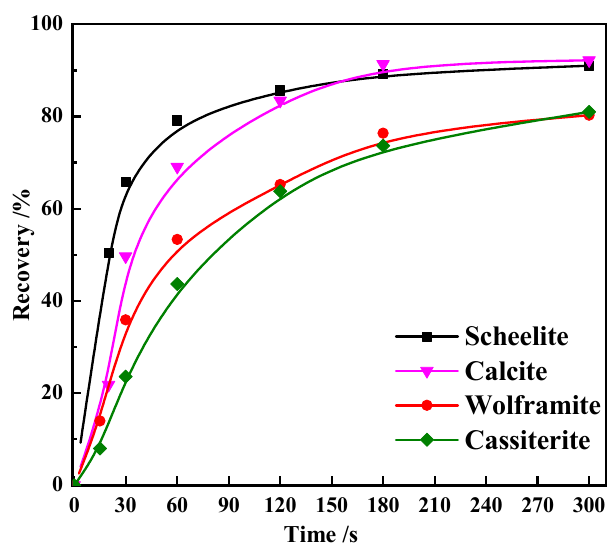
Figure 3. Difference in the flotation rate of scheelite, calcite, wolframite, and cassiterite using Pb–BHA complexes (C BHA = 1.5 × 10 −4 mol/L, and C Pb = 2.5 × 10 −4 mol/L, pH = 9.5).